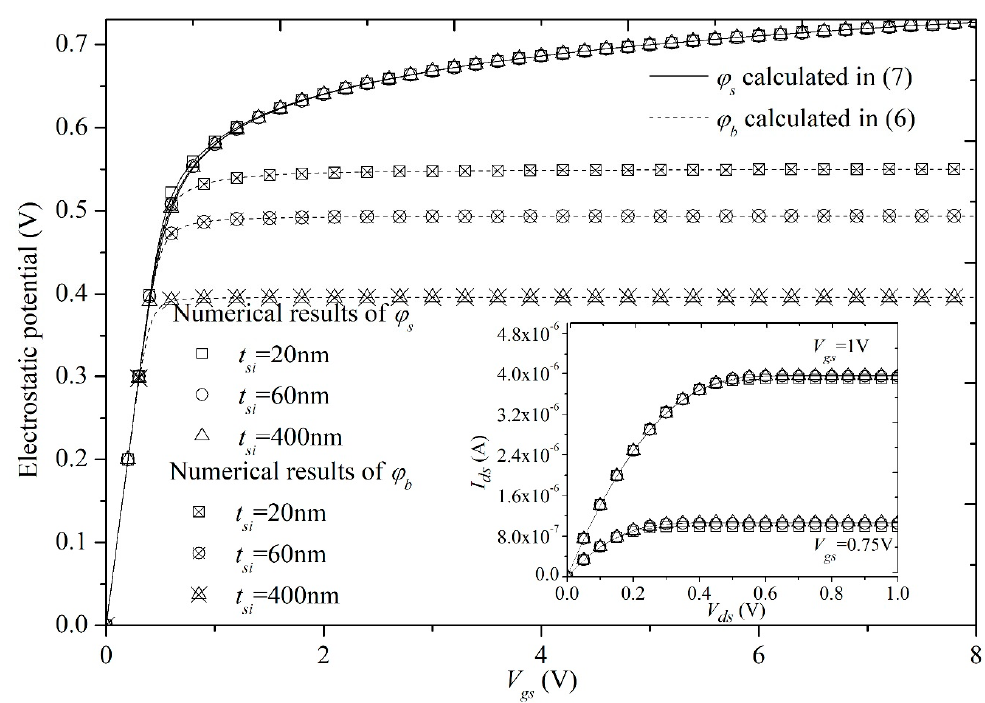
Figure 9. Comparisons between the surface potential calculation scheme and numerical results for different t si , and the drain current in (11).